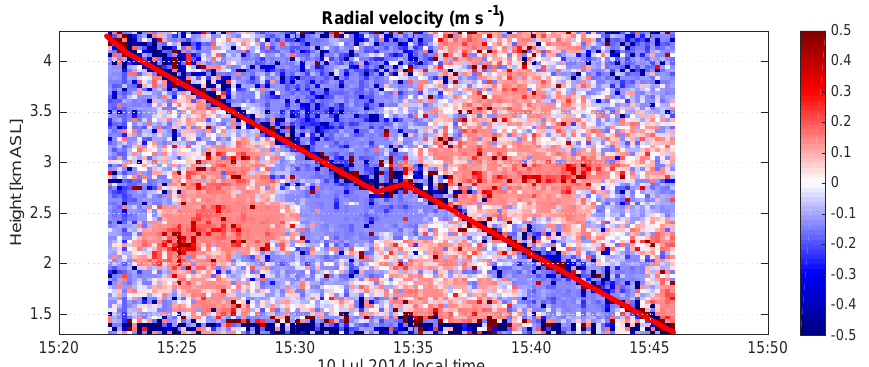
Figure 12. Similar to Fig. 6 but for the afternoon flight. Estimates of the vertical wind cannot be estimated from radar returns along the DataHawk path due to its high reflectivity.